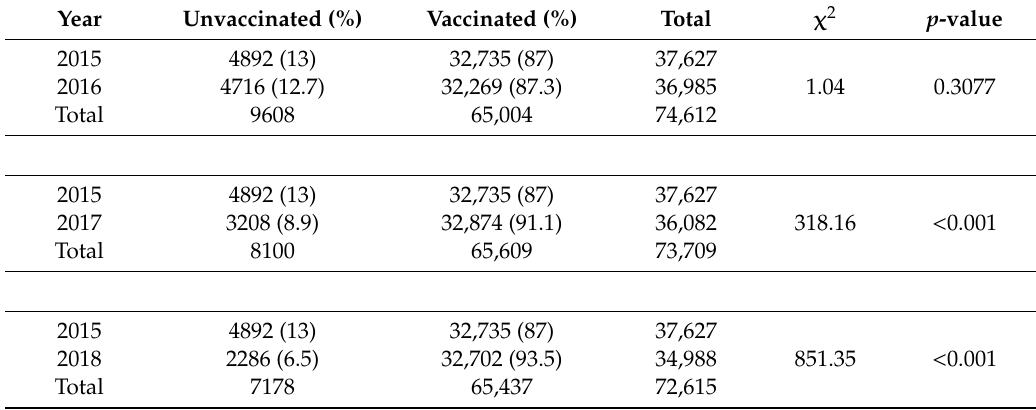
Table 4. Percentage of vaccinated and unvaccinated children in the Emilia-Romagna region in 2015 and comparisons with the following